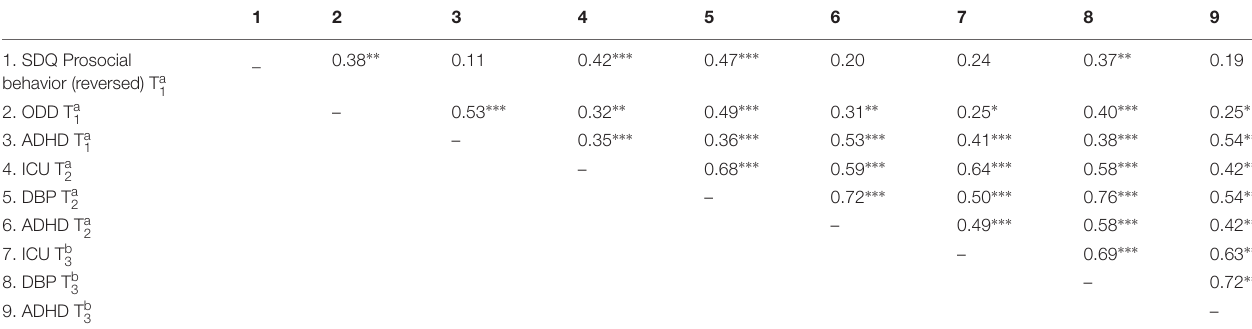
TABLE 2 | Inter-correlations between aggregated behavioral ratings.